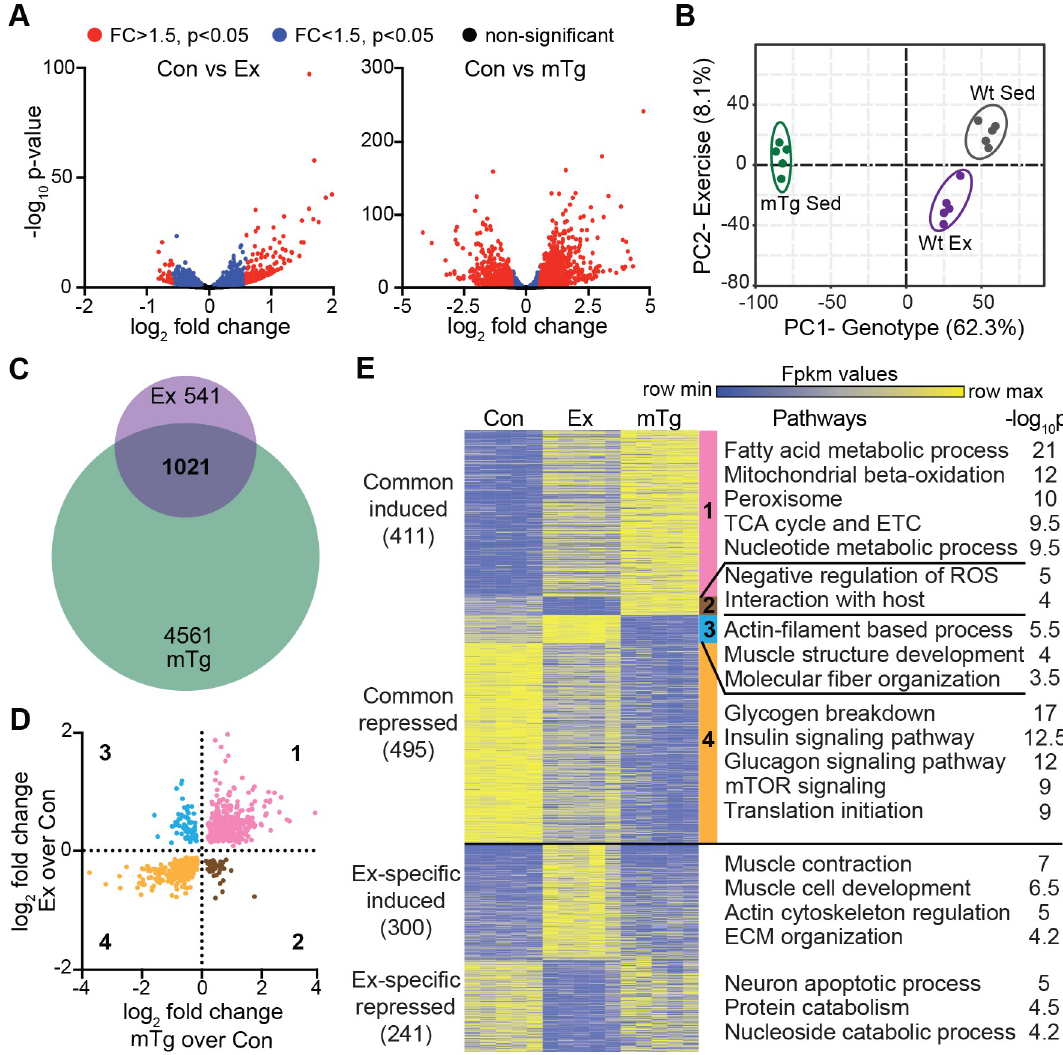
Fig 8. Exercise and Pgc1a overexpression convergently control gene expression. (A) Volcano plots showing log 2 FC in gene expression in Ex (left) or mTg (right) compared with Con quadriceps. Red represents absolute FC > 1.5 with an adjusted p - value < 0.05, blue represents p -value < 0.05, and black represents nonsignificant genes ( n = 5/group). (B) Principal component analysis of all significantly altered genes ( p < 0.05) in Ex or mTg compared with control. (C) Venn diagram showing transcriptional overlap in Ex and mTg. (D) Quadrant plot of log 2 FC in gene expression in Ex/Con versus log 2 FC in mTg/Con. (E) Heatmap of K- means clustering of transcriptomic profiles for differentially expressed genes. The number of genes in each cluster is in parenthesis. Each cluster, indicated by a vertical color bar, corresponds to quadrant colors from the previous panel. Two clusters were unique to Ex-regulated genes (bottom). Pathways enriched in each cluster and corresponding − log 10 p -values are shown on the right. Numerical values for all panels are available in S1 Data. Con, control; ECM, extracellular matrix; ETC, electron transport chain; Ex, exercised; FC, fold change; Fpkm, Fragments Per Kilobase of transcript per Million mapped reads; mTg, muscle-specific Pgc1a transgenic; mTOR, mammalian target of rapamycin; PC1, principal component 1; PC2, principal component 2; Pgc1a , peroxisome proliferator– activated receptor gamma, coactivator 1 alpha; ROS, reactive oxygen species; Sed, sedentary; TCA, citric acid cycle; Wt,